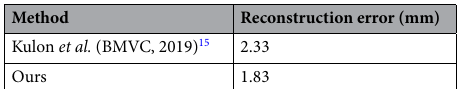
Table 5. L1 Reconstruction error which was obtained for the Dome dataset 15 .